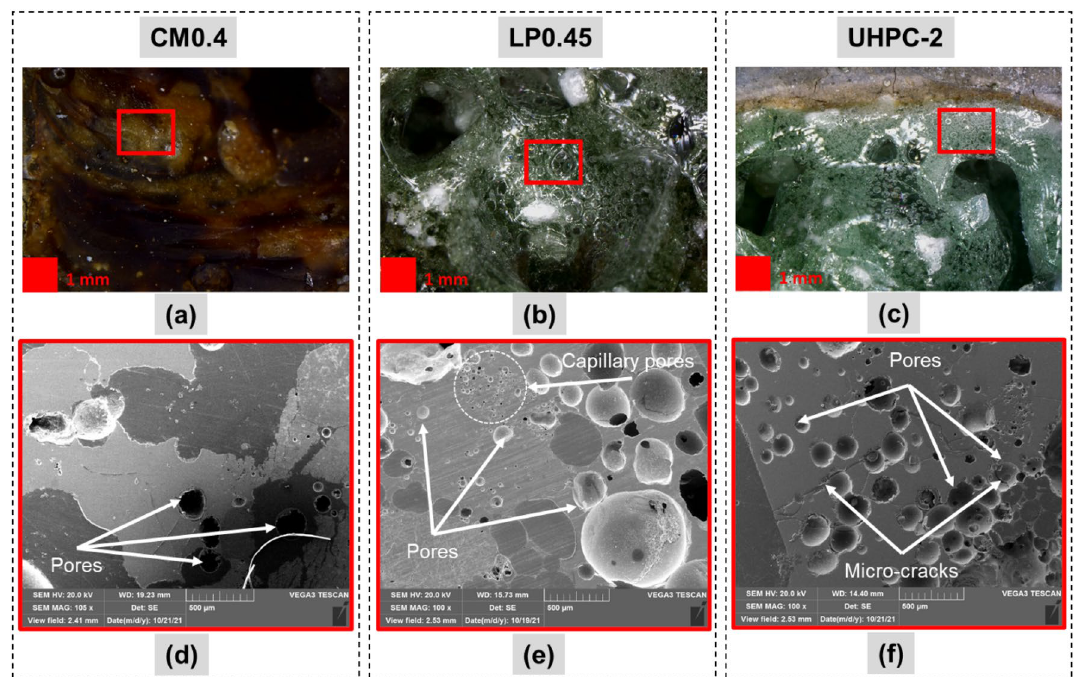
Figure 13. The bubble appearance in the top ( a – c ) and pore structure ( d – f ) in the cross-section of the glassy layer at the laser scanning speed of 5